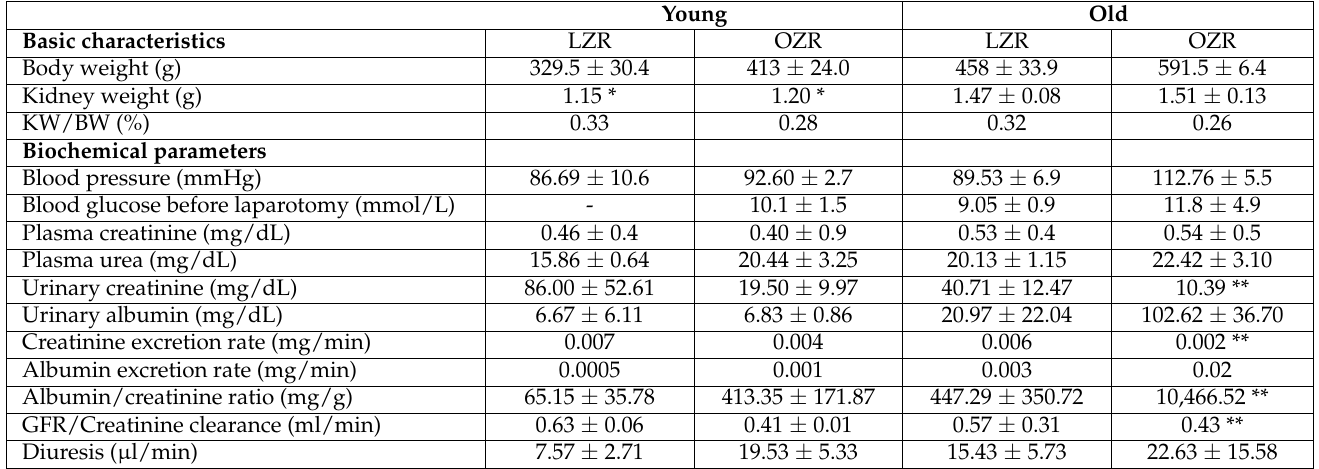
Table 1. Basic characteristics and biochemical parameters measured at study end in lean Zucker rats (LZR) and obese Zucker rats